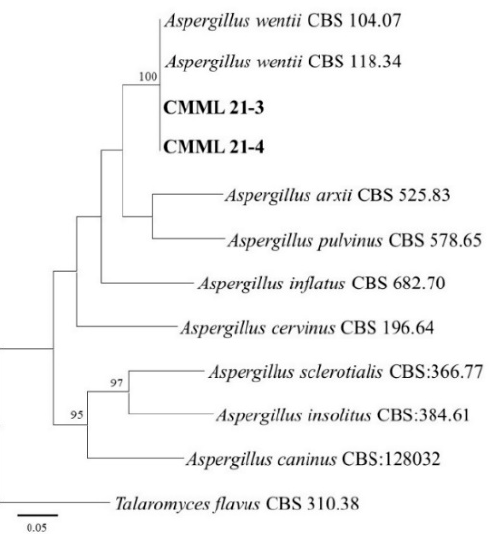
Figure 3. Maximum likelihood tree of the Aspergillus isolates (CMML21–3 and CMML21–4) inferred from the combined data sets of the ITS, BT, and CAL gene sequences constructed by the MEGA X program. The tree is rooted to Talaromyces flavus CBS 310.38. Numbers on the branches indicate the bootstrap values. The scale bar indicates expected changes per site. The isolates from the present study are indicated in bold.